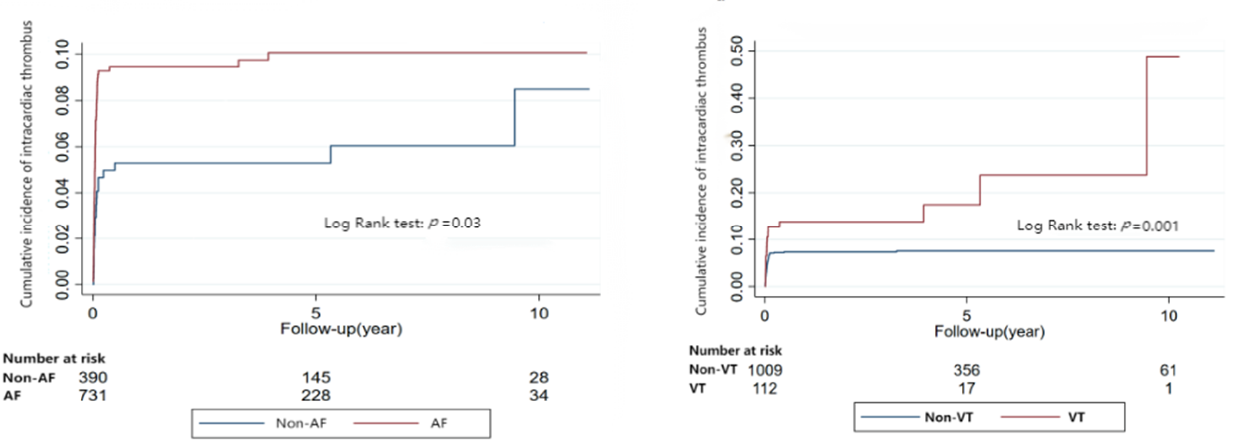
Figure 2. Relationship between arrhythmia and intracardiac thrombus in restrictive cardiomyopathy (Kaplan-Meier Analyses).